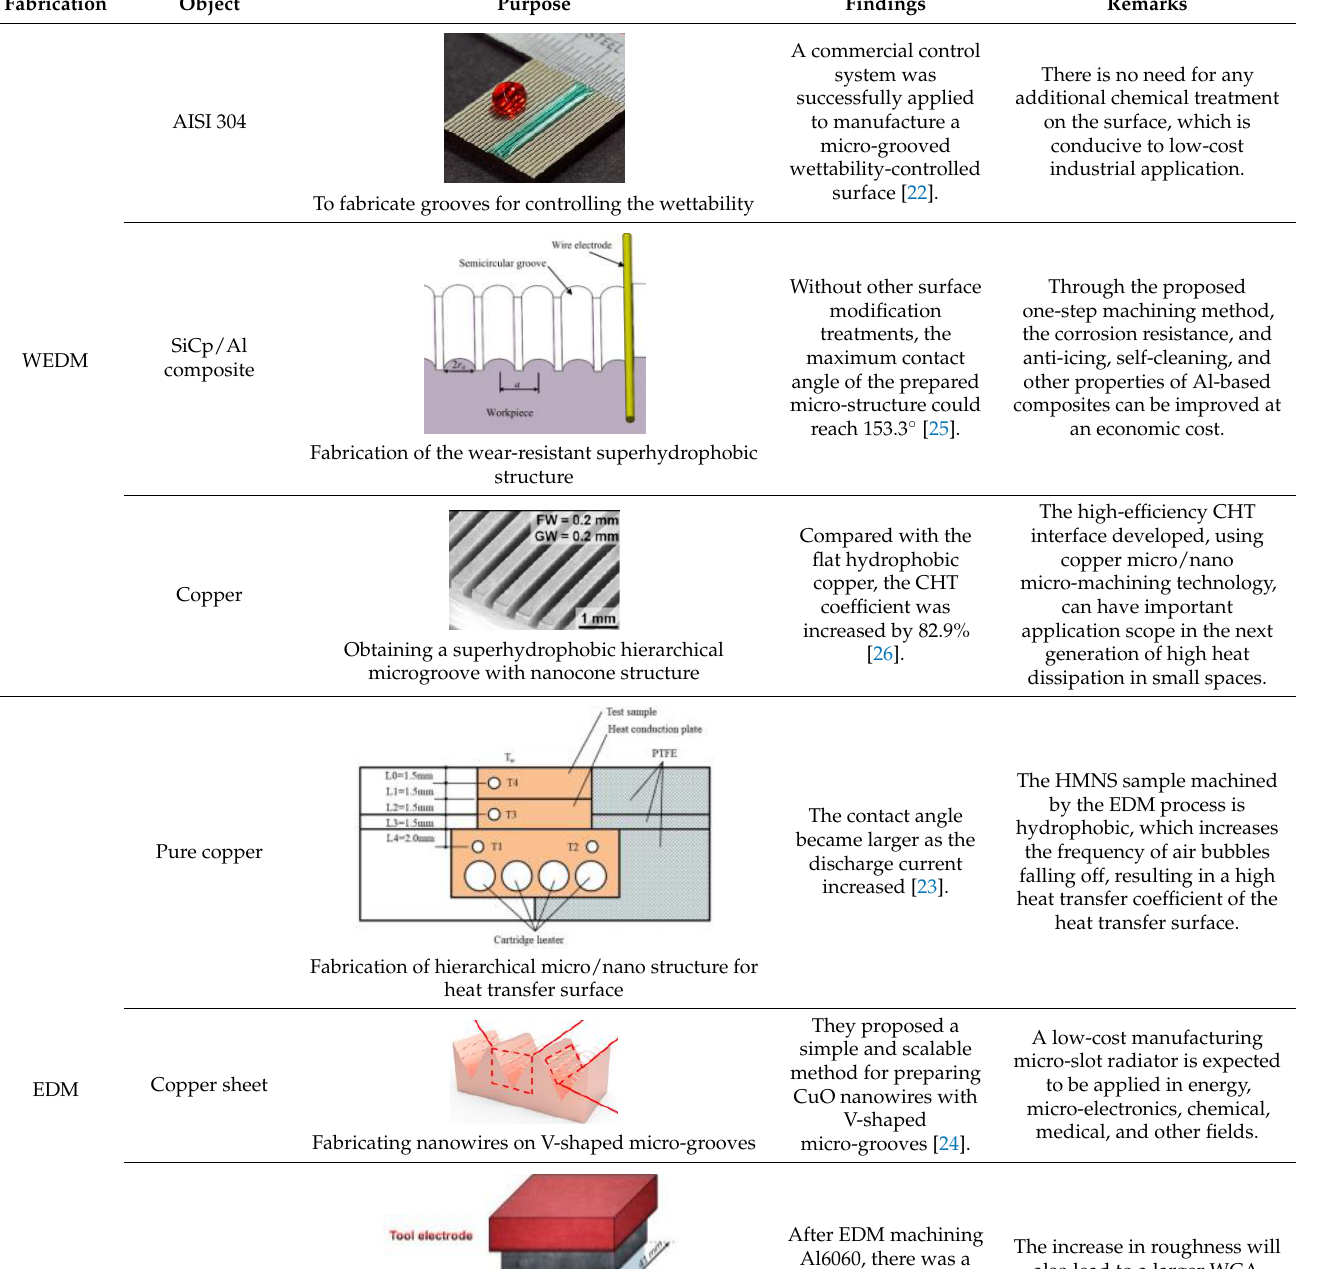
Figure 11. Relationship between designed parameters of the groove and the contact state [25]. ( a ) The original sample (3); ( b ) the sample (3) with deep groove; ( c ) the original sample (4); ( d ) the sample (4) with deep groove. Table 2. Summary of the process of EDM described in the text grouped by machining type and object fabricated. Fabrication